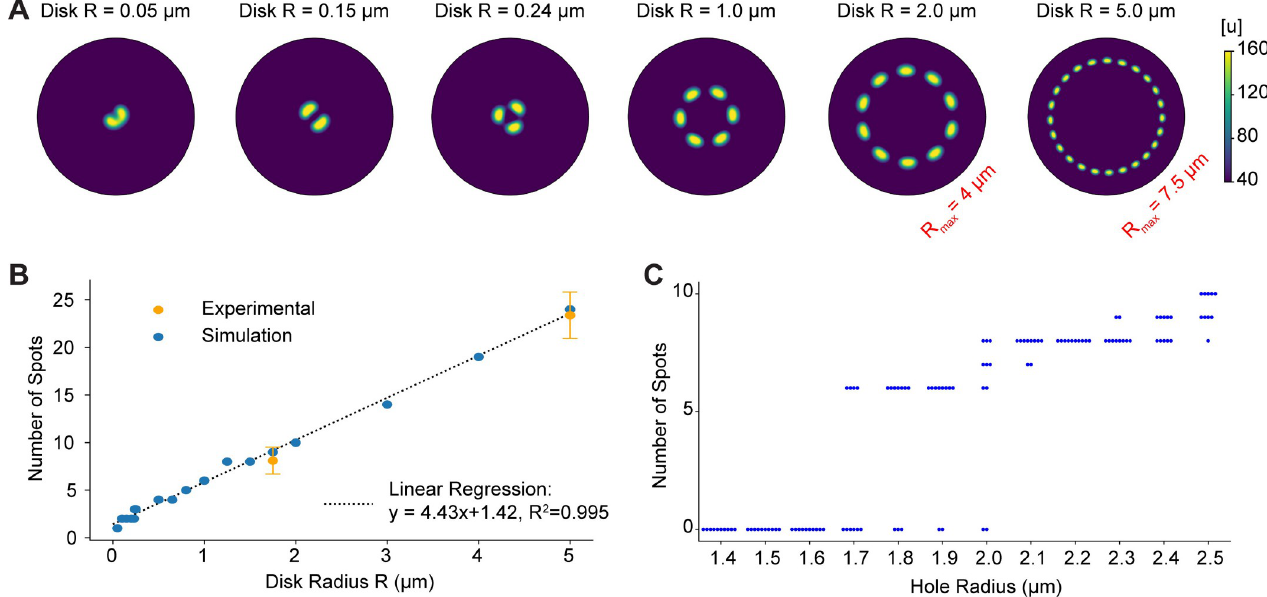
Fig 6. Effects of varying the size of IgG disks and holes. A) Simulation results for various disks using the representative parameter set (Table 2). The radius of the simulation domain is 4.0 μ m except for the case with a disk size of R = 5.0 μ m (far right), where the domain radius is 7.5 μ m. B) The number of active GTPase spots linearly increases with disk sizes (blue circles). These results are consistent with experimental results (orange circles display the median, whiskers denote one standard deviation). C) Number of active GTPase spots versus hole size. The system appears bistable for radii between 1.7 and 2.0 μ m. In this region rosette formation depends on the initial conditions used in the